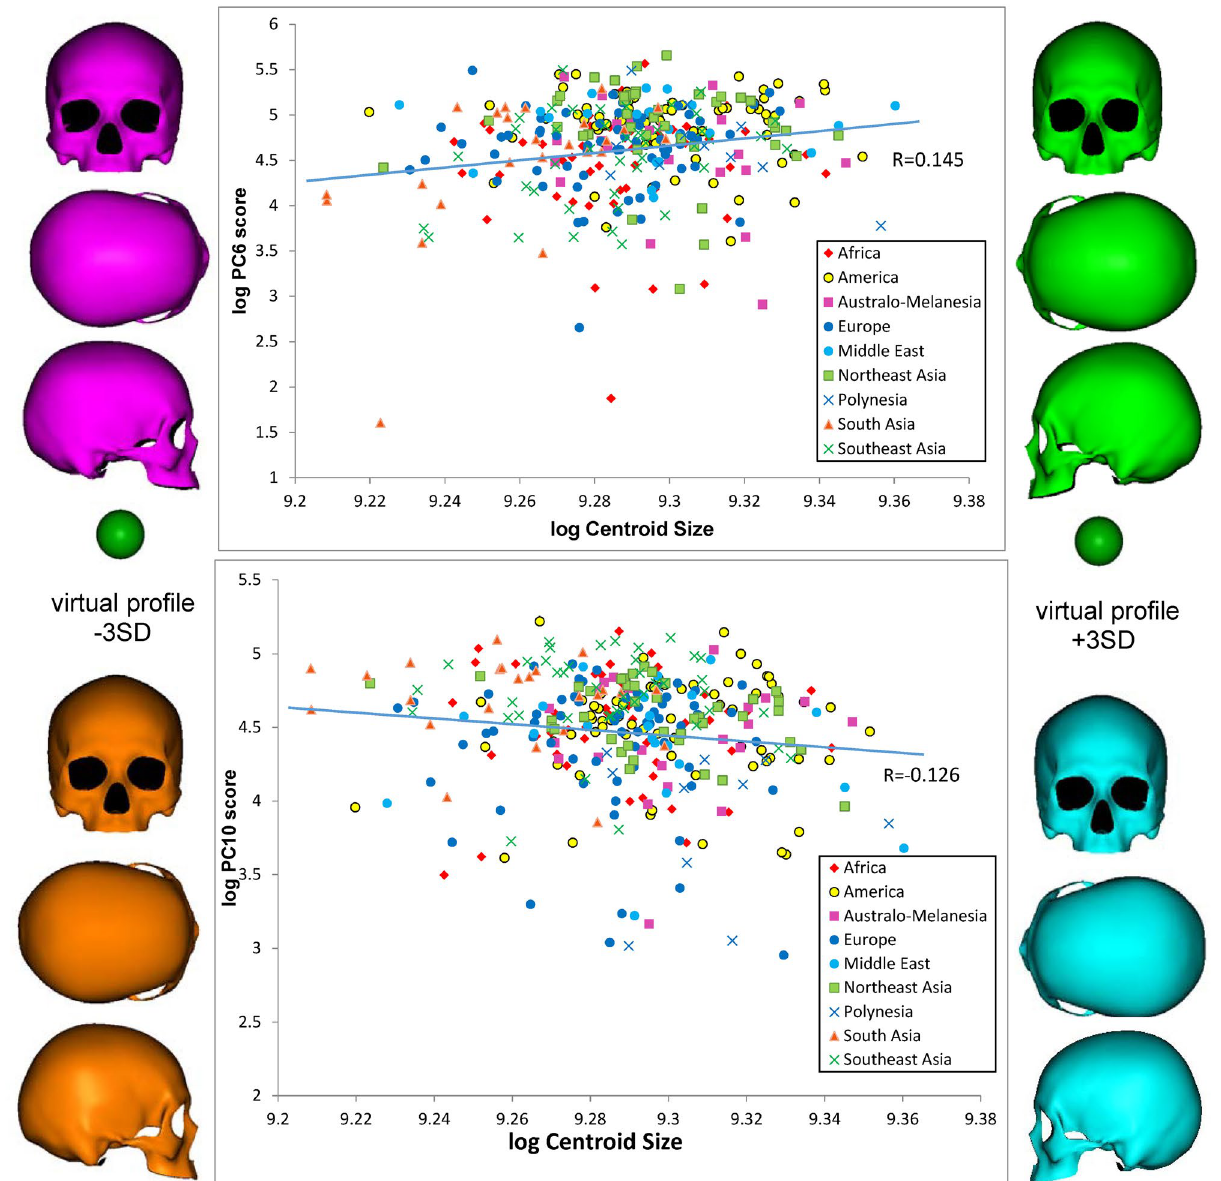
Figure 7. The regression slopes in log liner relations between the PC scores of shape components (derived from normalized data) and centroid sizes, with virtual shape deformations having a magnitude of 3 SD at the opposite sides of the lines, for the significant allometric relationships listed in Table